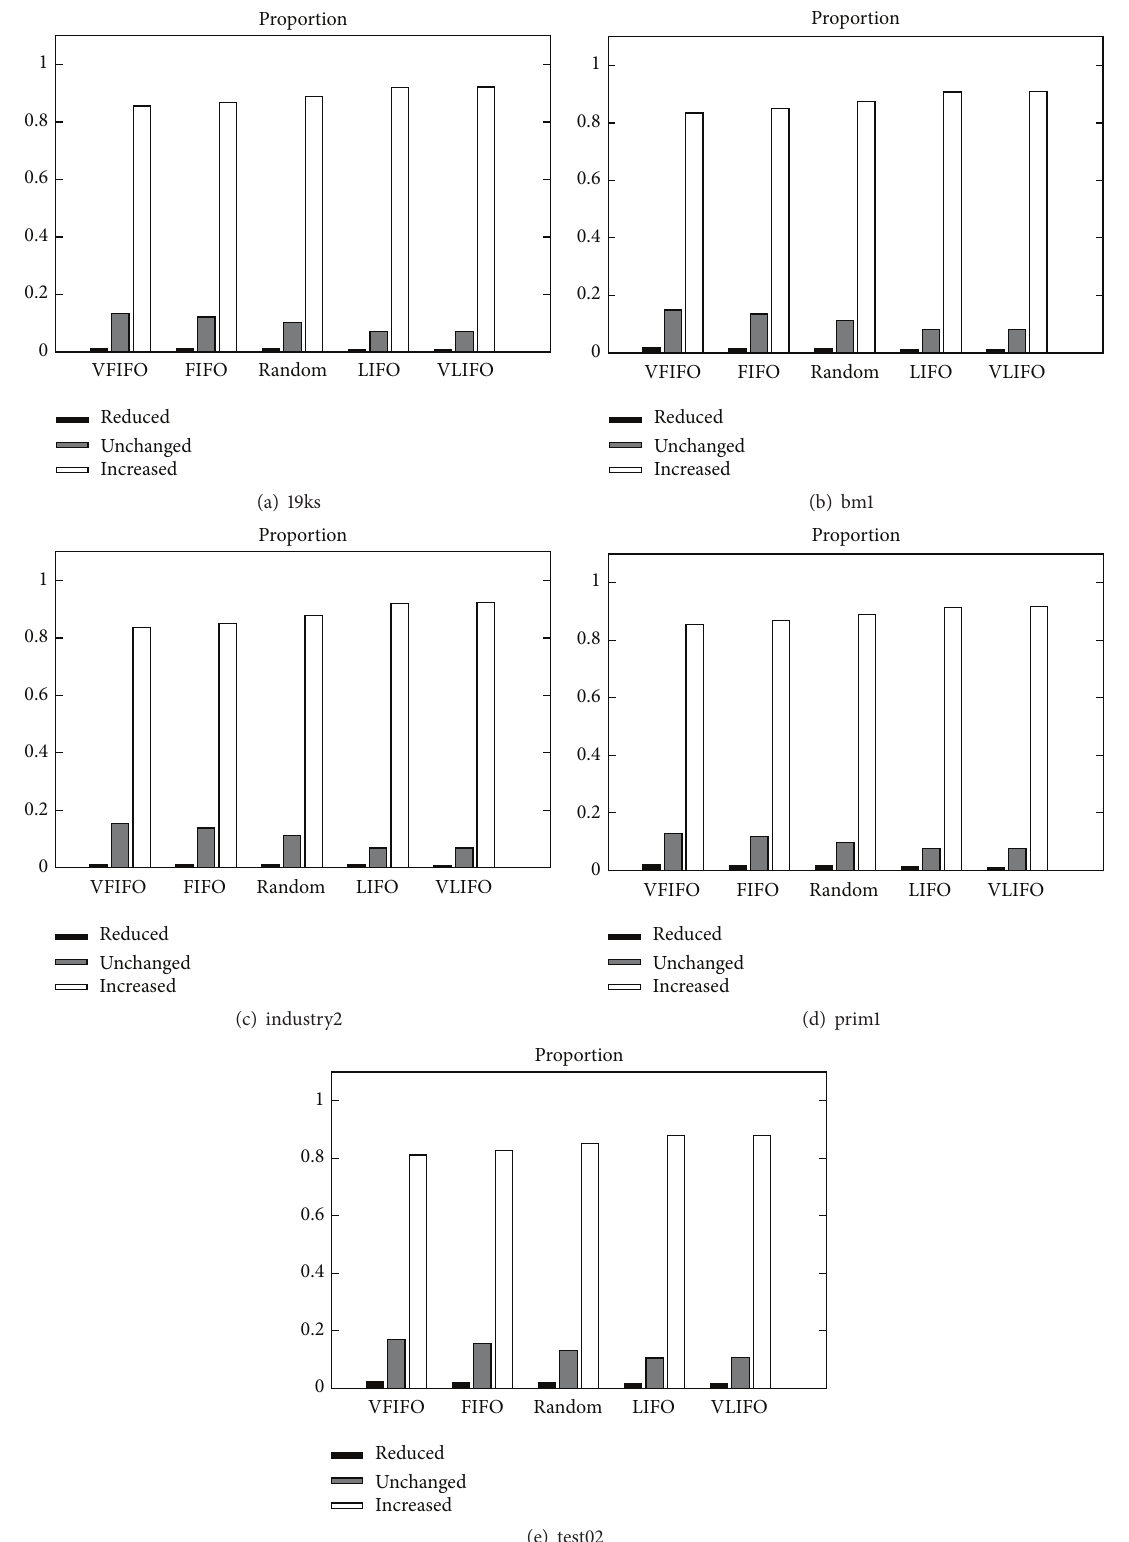
Figure 4: Proportion of modules selected for moving with gain reduced, unaffected, or increased by the previous move, for five circuits (a)–(e) (data from Table